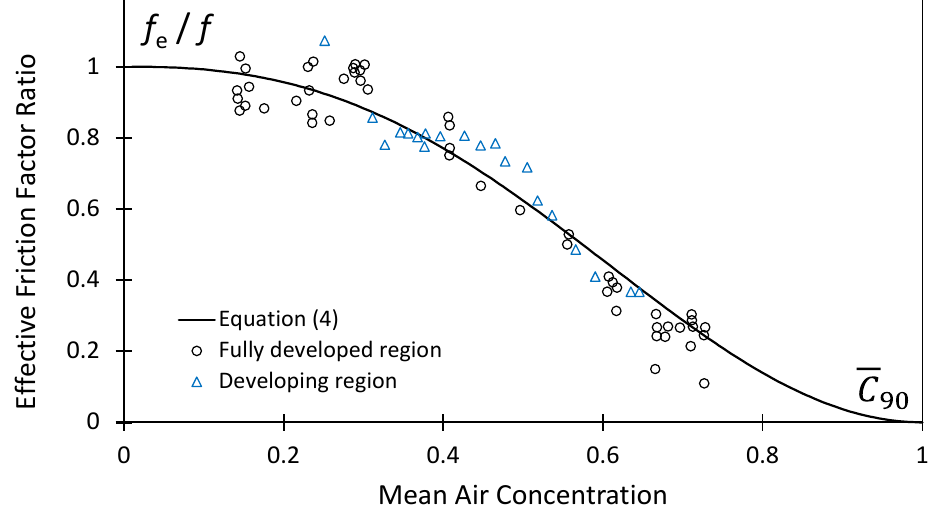
Figure 4. Curve relating aerated vs. non-aerated friction factor ratio to air concentration [9,43].